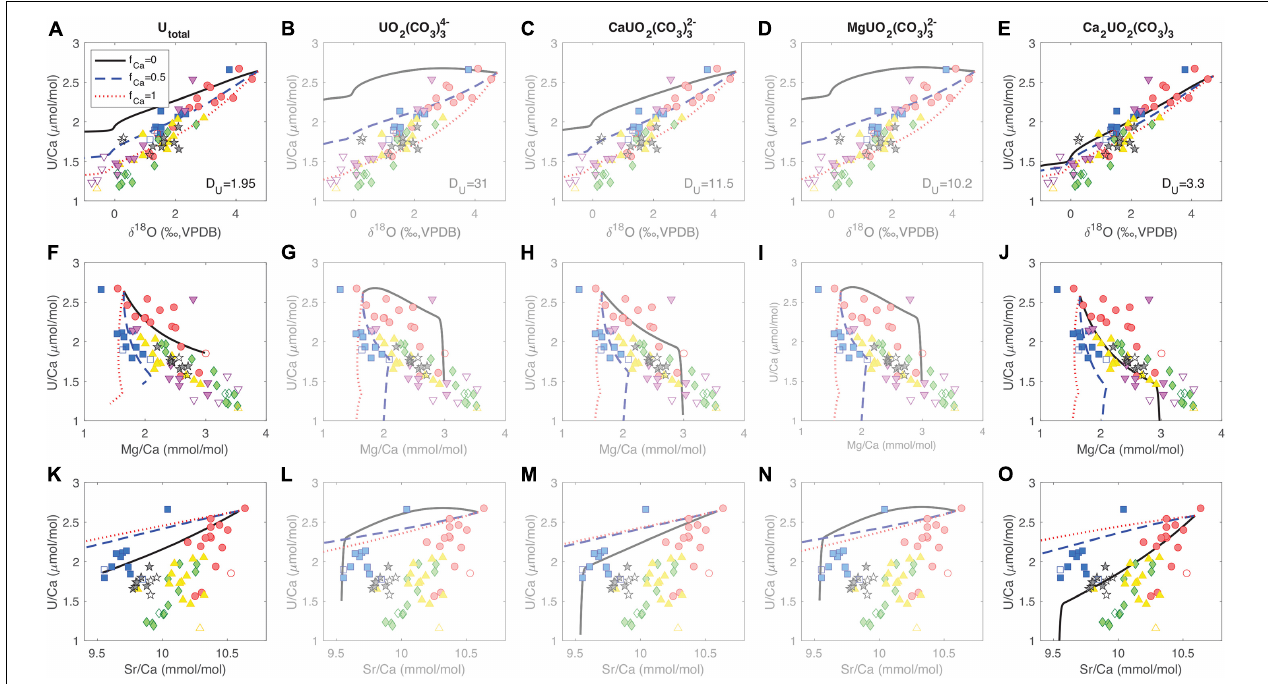
FIGURE 7 | Comparison of tracer correlation patterns between the data and the model. Each row (A–E,F–J,K–O) shows a different tracer correlation from the micromill data as in Figure 3 . Each column (AFK,BGL,CHM,DIN,EJO) corresponds to tracer correlations predicted by the model assuming a certain uranium species that gets incorporated into the coral skeleton. The three curves correspond to different f Ca values in each panel ( f Ca = 0 black solid, f Ca = 0.5 blue dashed, f Ca = 1 red dotted). The uranium distribution coefficients (D U ) required to fit the range in U/Ca is listed in Row 1 corresponding to each species. Transparency shading is added to Columns 2–4 to emphasize the model cases with U total and Ca 2 UO 2 (CO 3 ) 3 that better fit the pattern in the